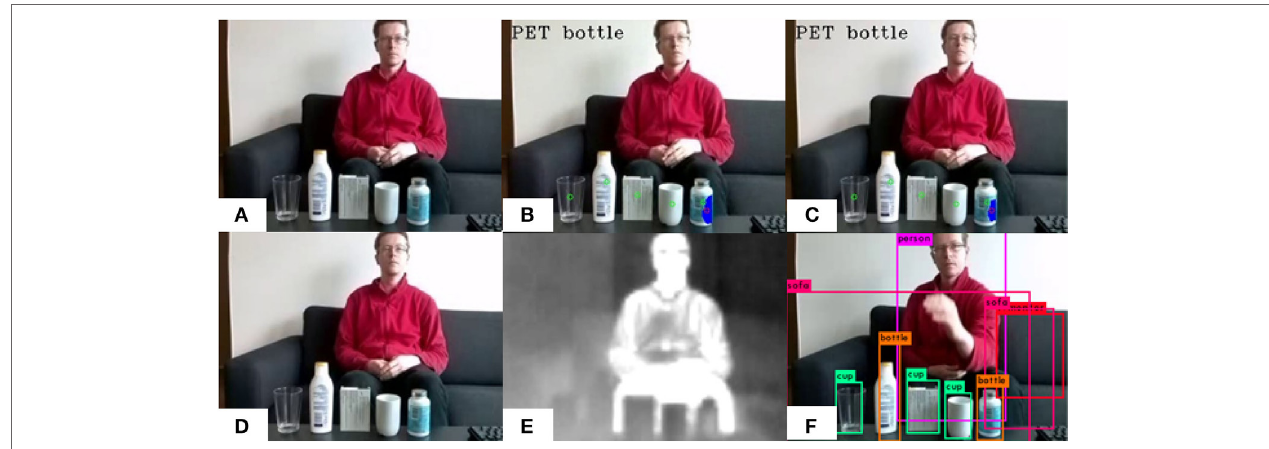
FigUre 12 | Some examples of detecting touches to medicine packages. (a) Time − 5 s: a true negative before touching, (B) time 0 s: a true positive immediately after touching (touch shown in blue by the algorithm), (c) time 30 s: the same touch after 30 s, where a decrease in area of the touch can be seen, (D) time 60 s: a false negative, the same touch is no longer detected, (e) time 60 s: the touch can still be seen by the naked eye in the thermal image, and (F) different touch: a rare false positive, caused by the black sofa in the background being mistaken as a TV monitor, and part of the experimenter’s leg as a touch. Consent has been obtained from the individual depicted (the first author) for the publication of this image.